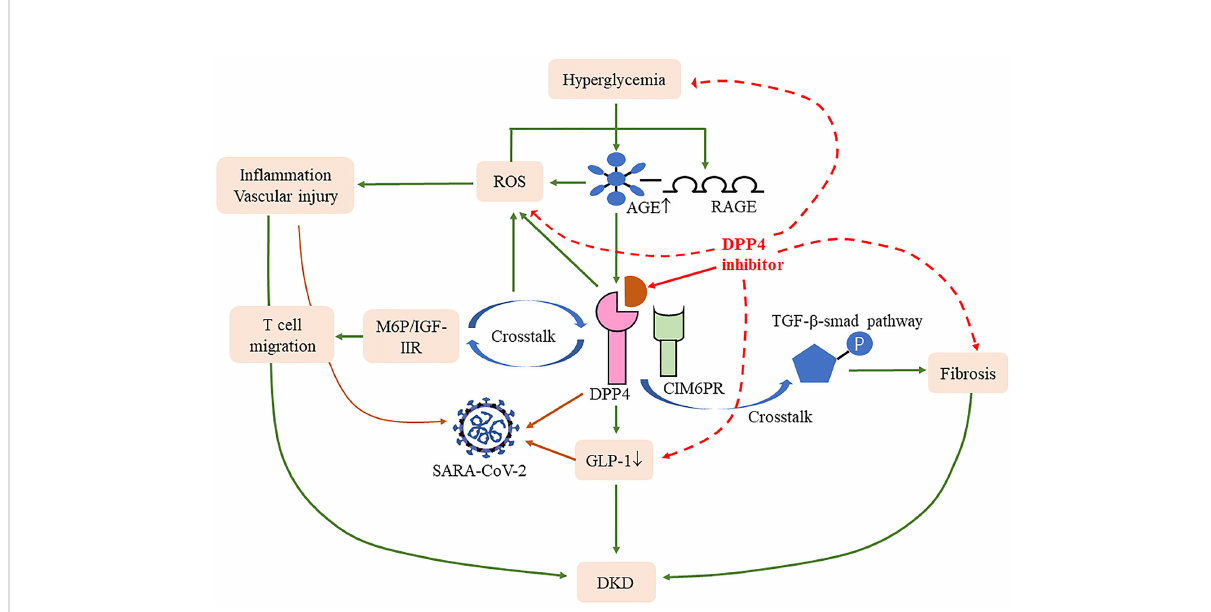
FIGURE 2 Effects of DPP4 and its inhibitors in COVID-19 and DKD. DPP4 cross talk with D-mannose-6-phosphate/insulin-like growth factor II receptor (M6P/IGF-IIR) (64) and cation-independent mannose-6-phosphate receptor (CIM6PR) (59) induced reactive oxygen species (ROS) and fi brosis, respectively. Meanwhile, DPP4 also induced the degradation of glucagon-like peptide-1 (GLP-1), all of which contribute to the progression of DKD and COVID-19. DPP4 inhibitions blocked these processes and thus improved the disease